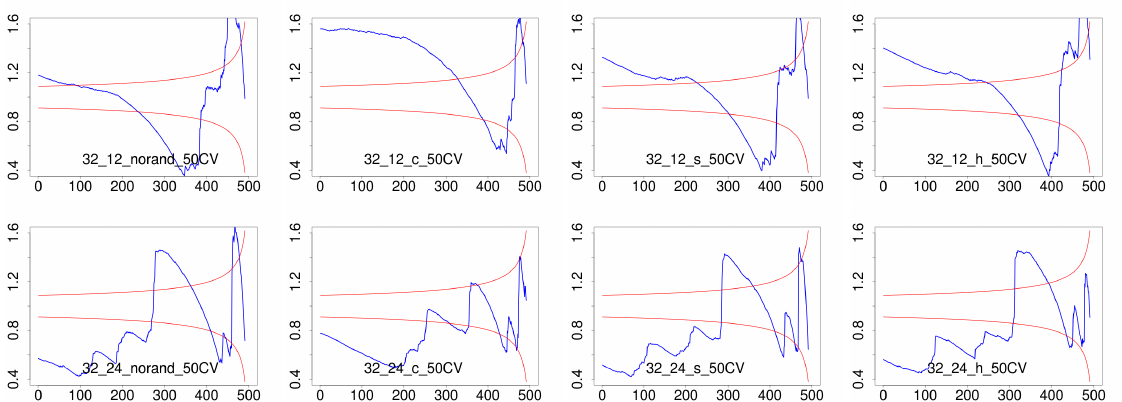
Figure 7. CV-plot for the FWI application for a problem size of 32 × 32 × 32. Plots correspond from left to right to no randomization, code randomization, stack randomization, and heap randomization respectively; and from top to bottom to 1, 2, 4, 8, 12 and 24 threads respectively.